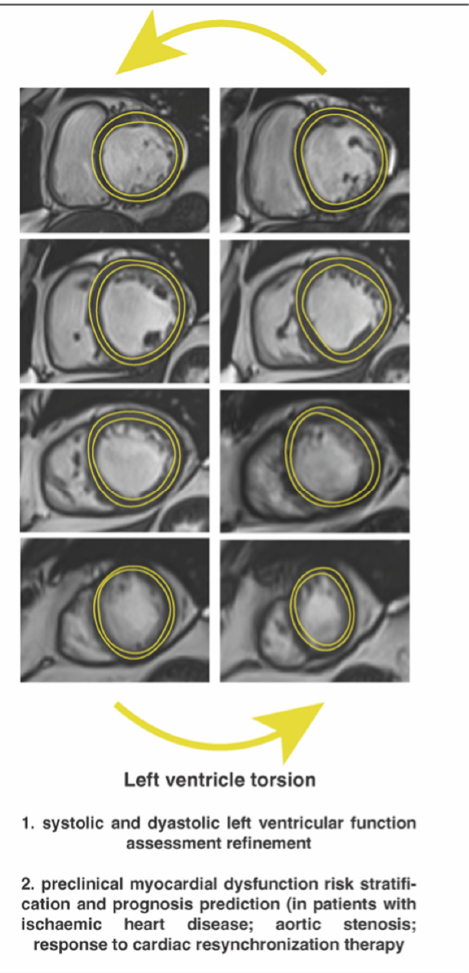
Figure 1. Left ventricle torsion by feature ‐ tracking cardiac magnetic resonance